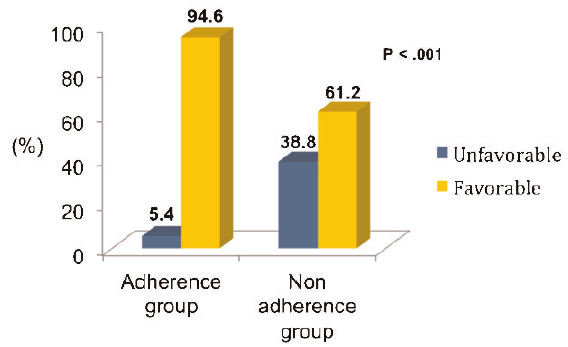
Figure 1 - Association between adherence to recommendations and clinical